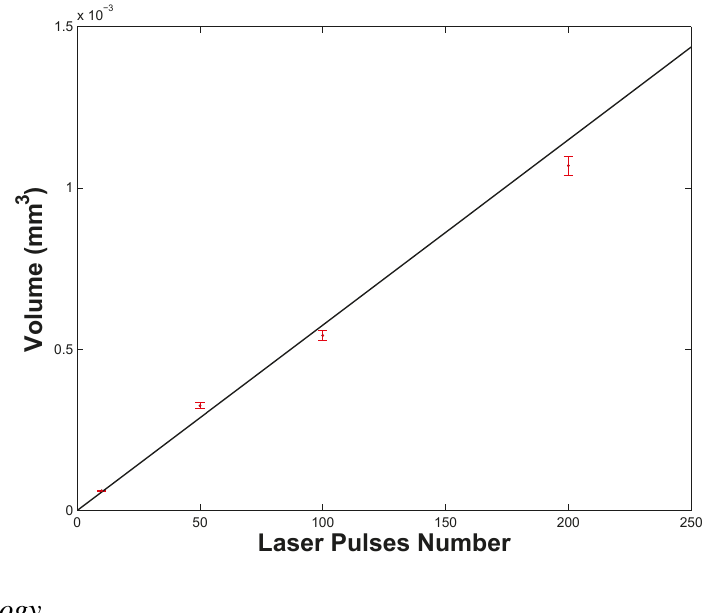
Figure 2. Crater volumes on the surface of a silver target as a function of the laser shot number. The line is a linear fit to the